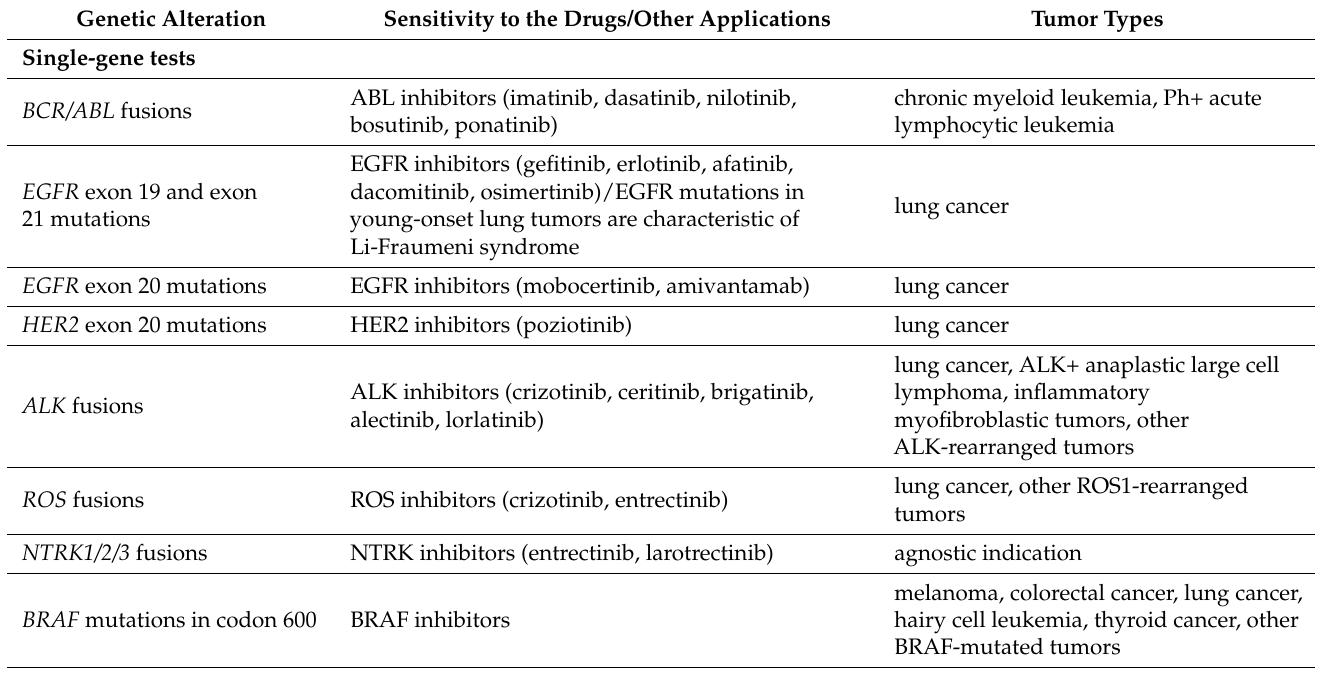
Table 1. Selected examples of single-gene assays and integrative genomic tests utilized in clinical